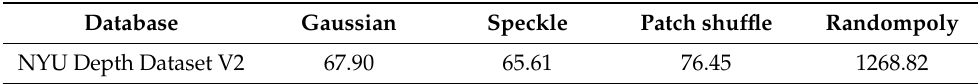
Table 10. The computational complexity comparisons between different types of random noise for DIBR distortion simulation (milliseconds (ms)).